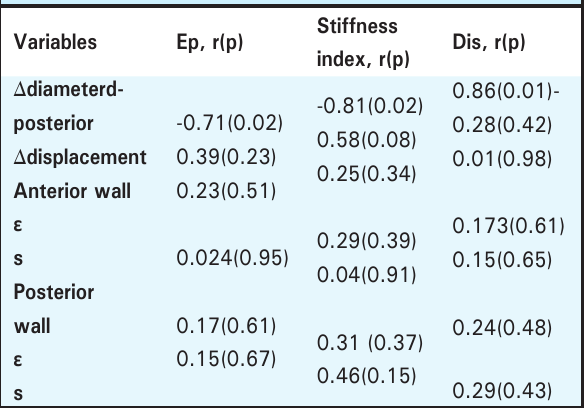
Table 3. The Pearson correlation analysis between the ∆diameter, d-posterior, ∆displacement, ε , s and Ep, β Stiffness index, distensibility in patients with hypertension.